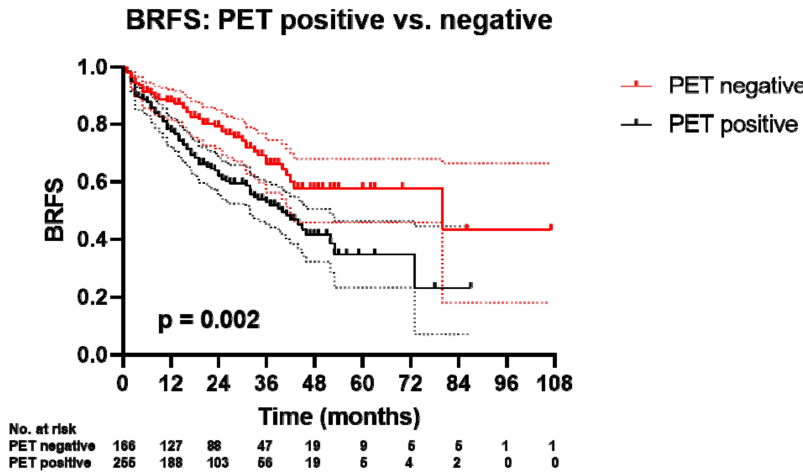
Figure 2. Kaplan–Meier curve of BRFS PET-positive vs. PET-negative patients. Plotted symbols represent censored points. Error bars show 95% confidence interval. p value was obtained with log-rank